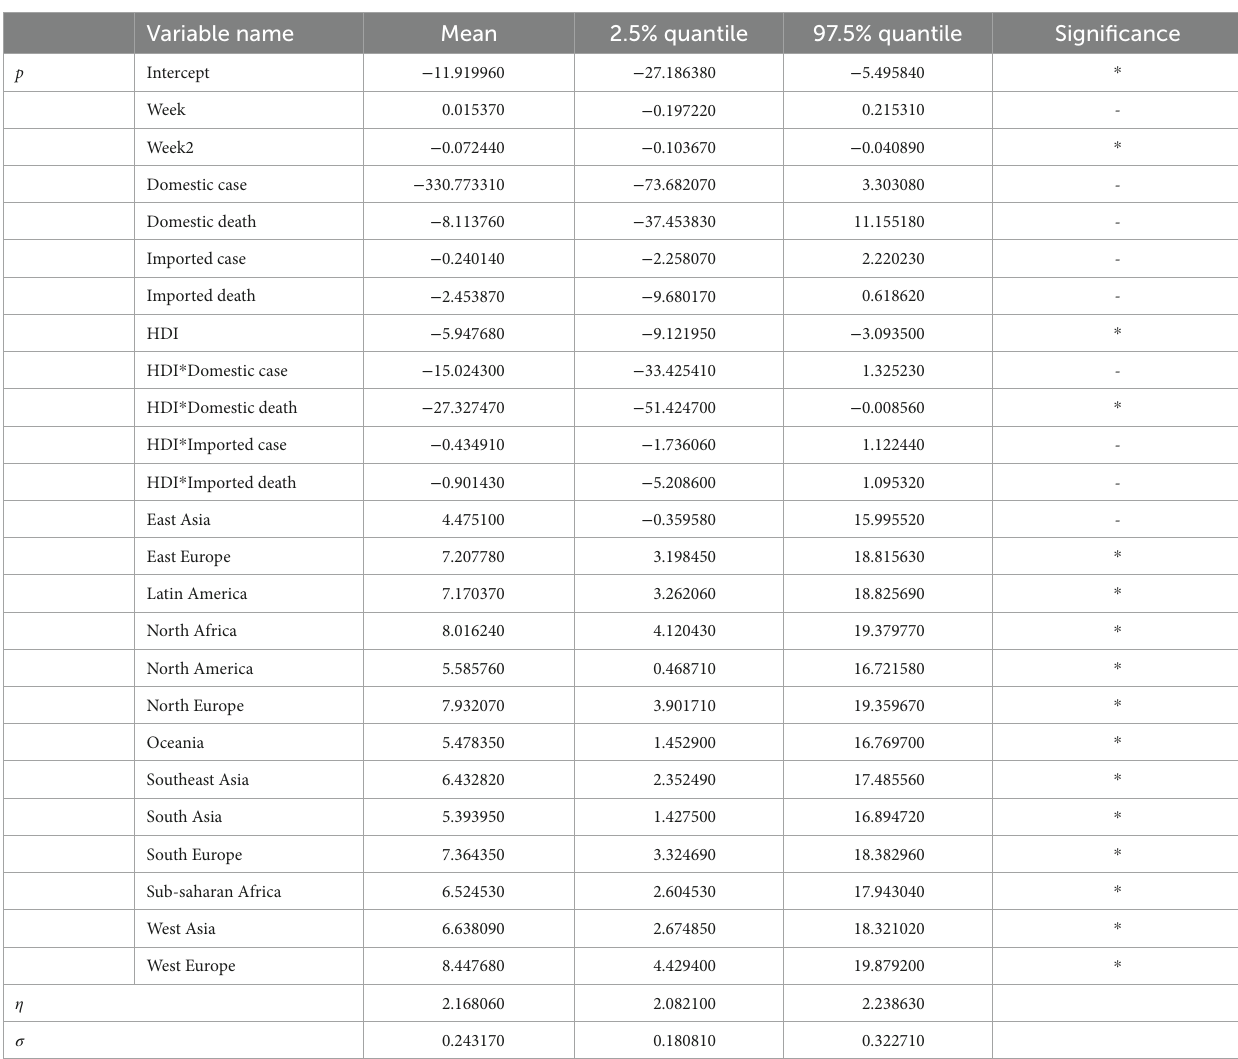
TABLE 3 ZOIB model result